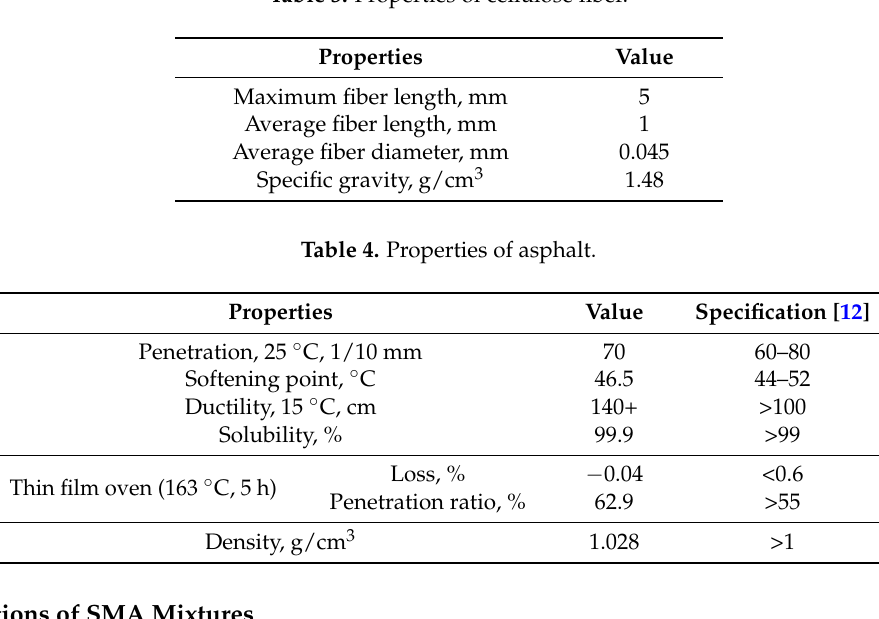
Table 3. Properties of cellulose fiber.